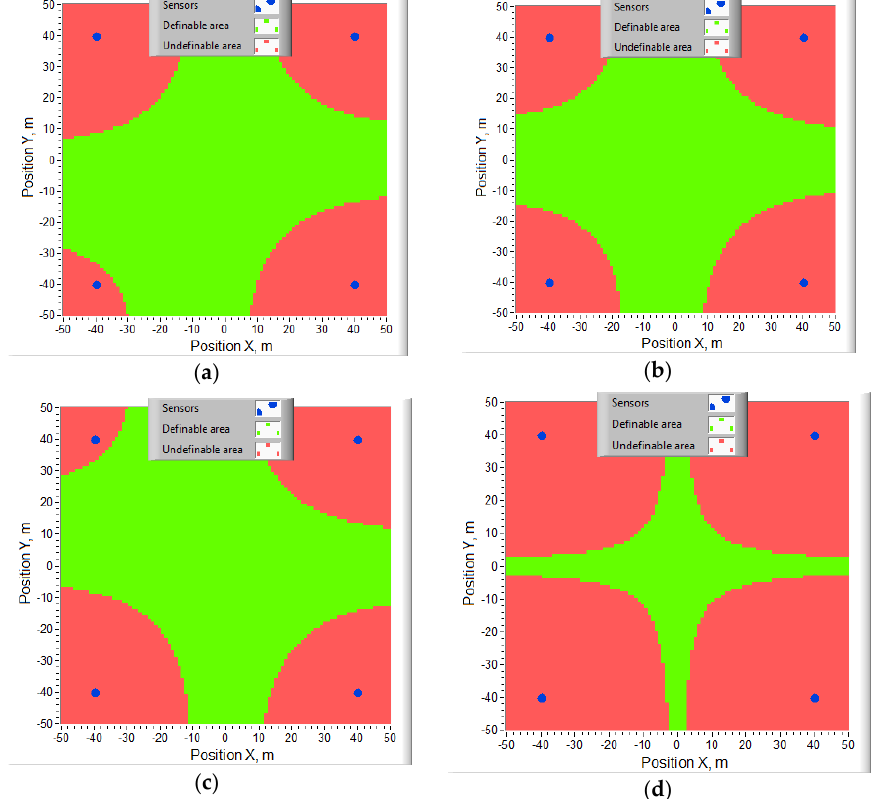
Figure 2. Areas in which the target coordinates are not determined by the algorithm [67]: ( a ) z = 0 m; ( b ) z = 15 m; ( c ) z = 30 m; ( d ) z = 0 m when z C,L,R,U = 8; 10; 12; 14 m.